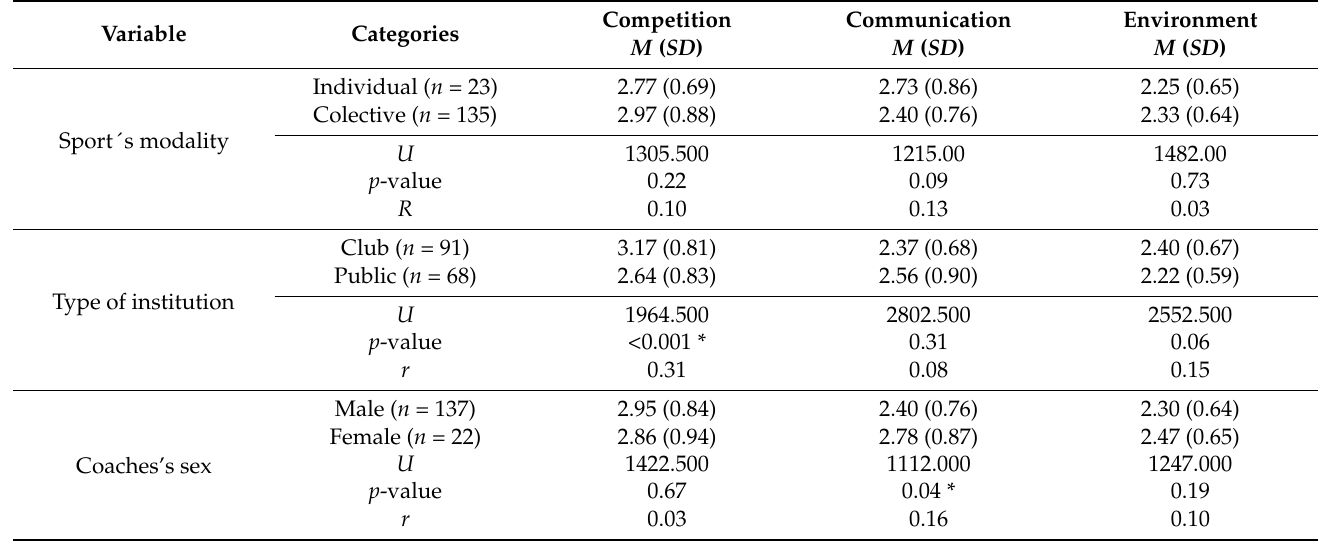
Table 2. Differences between the categories of the independent studied